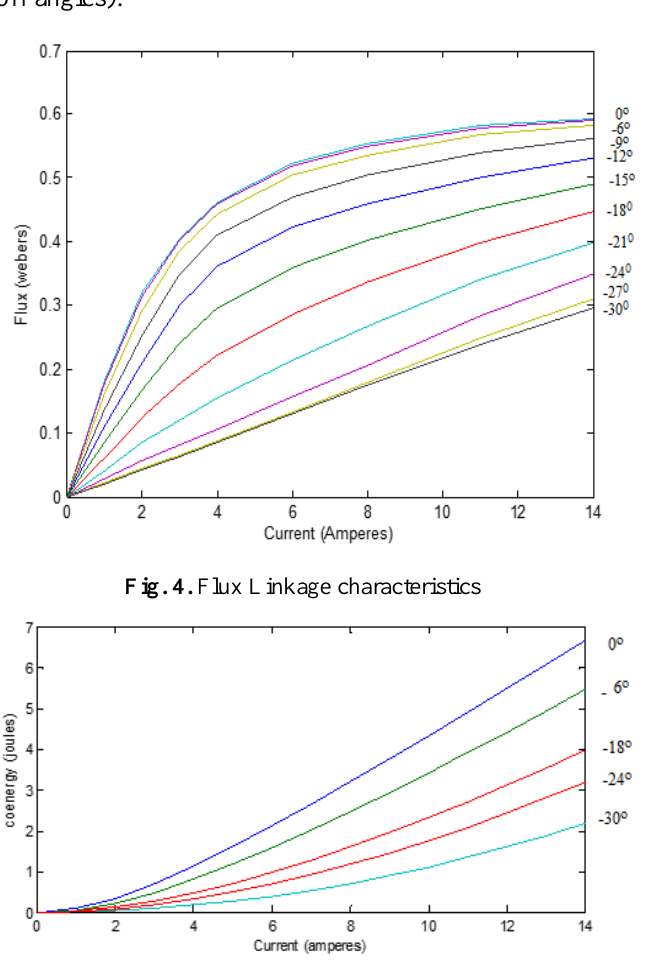
Fig. 5. Co-energy at different values of current